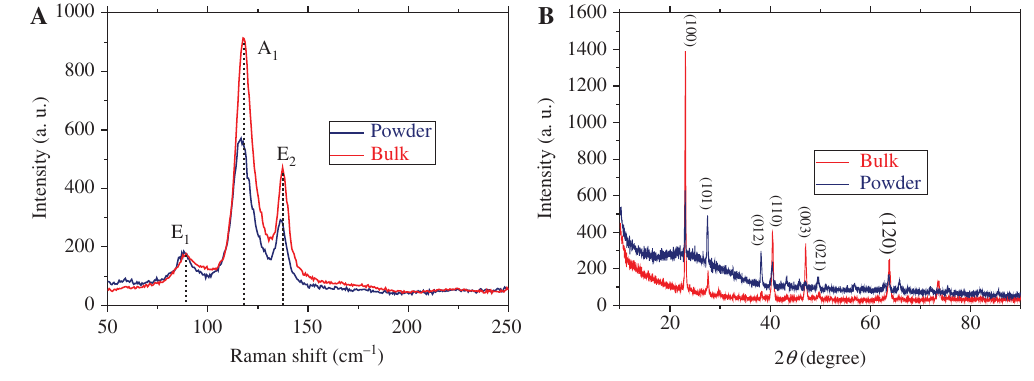
Figure 3: Raman and XRD characteristics of the tellurium. (A) Raman spectra of bulk tellurium and stripped powder and (B) XRD spectra of bulk tellurium and stripped powder.